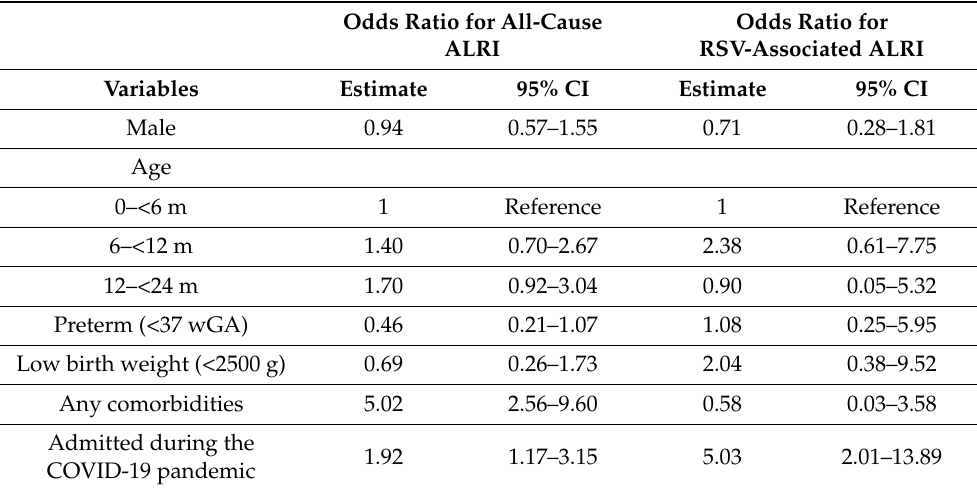
Table 2. Multivariate logistic regression results of the risk factors of severe or very severe illness of all-cause and RSV-associated ALRI